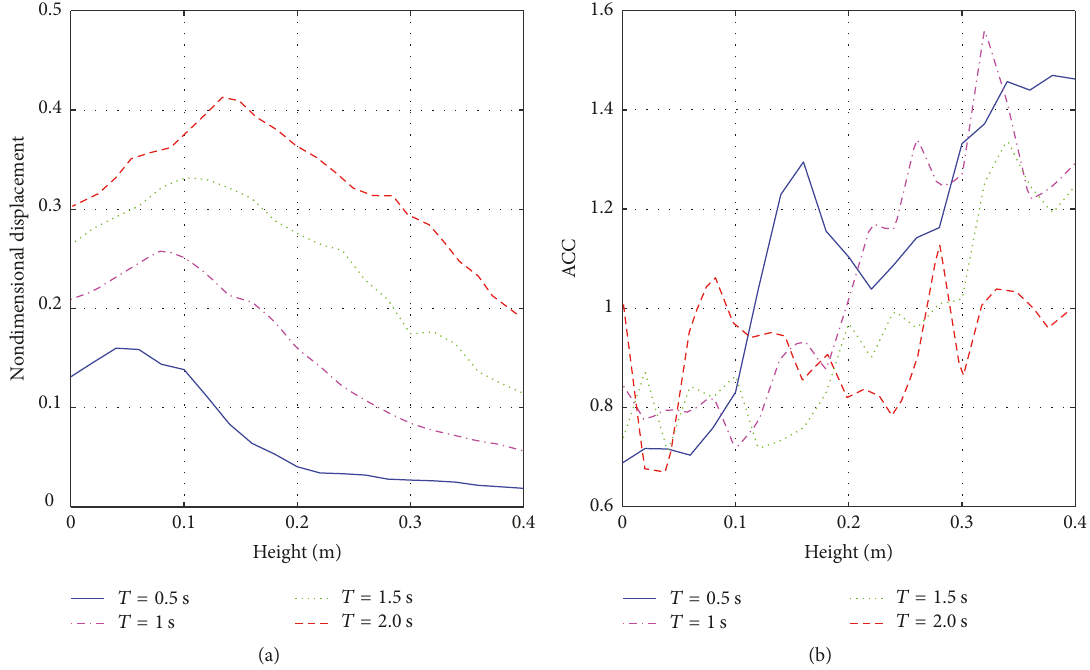
Figure 8: Comparison of nondimensional displacement and AAC for a seismic isolated structure with QZS ( 𝜉 = 0.05 ).